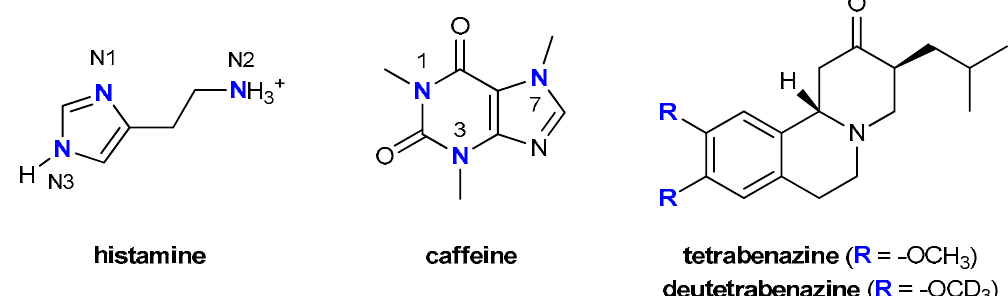
Figure 1. Chemical structures and atom labeling for the systems relevant to the discussion.